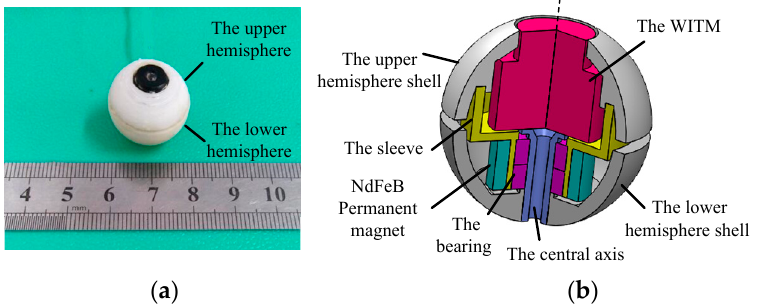
Figure 1. The structure of the dual-spin spherical capsule robot (DSCR). (a) The prototype, (b) the 3D cross-sectional view. cross-sectional view.